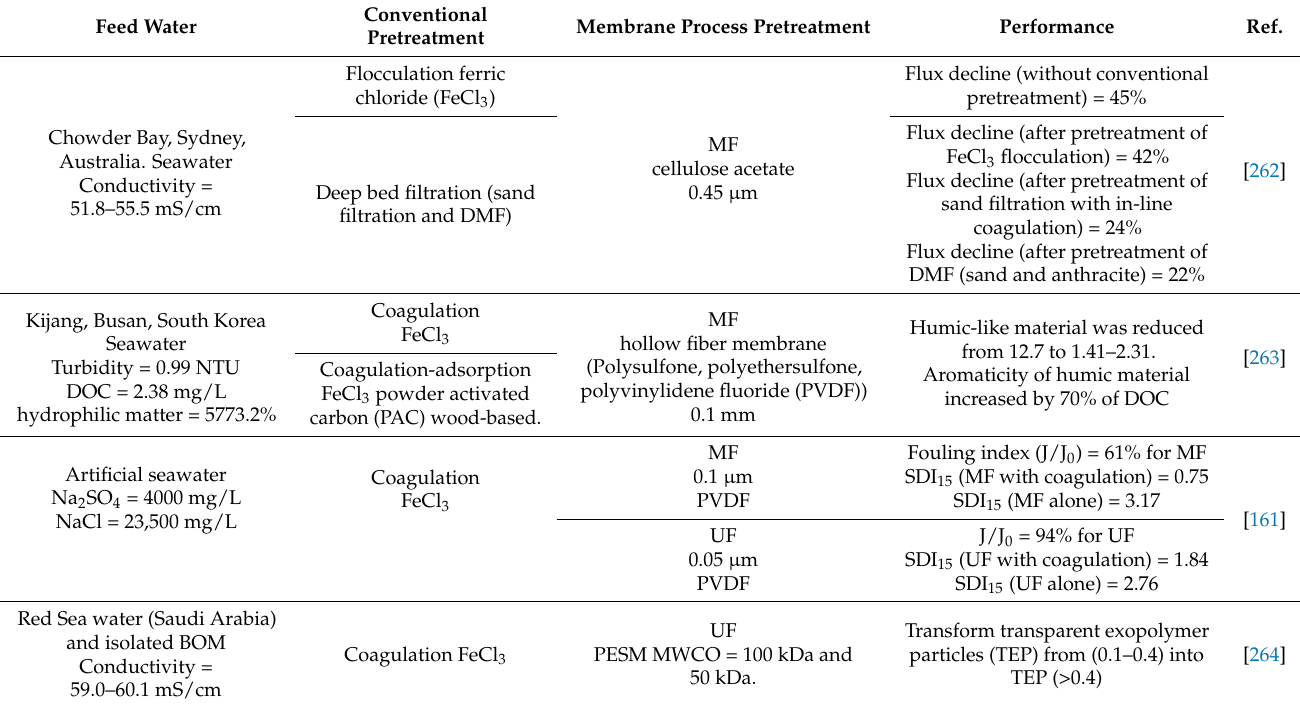
Table 11. Summary of research studies on hybrid systems used for RO pretreatment using membrane technologies coupled with conventional